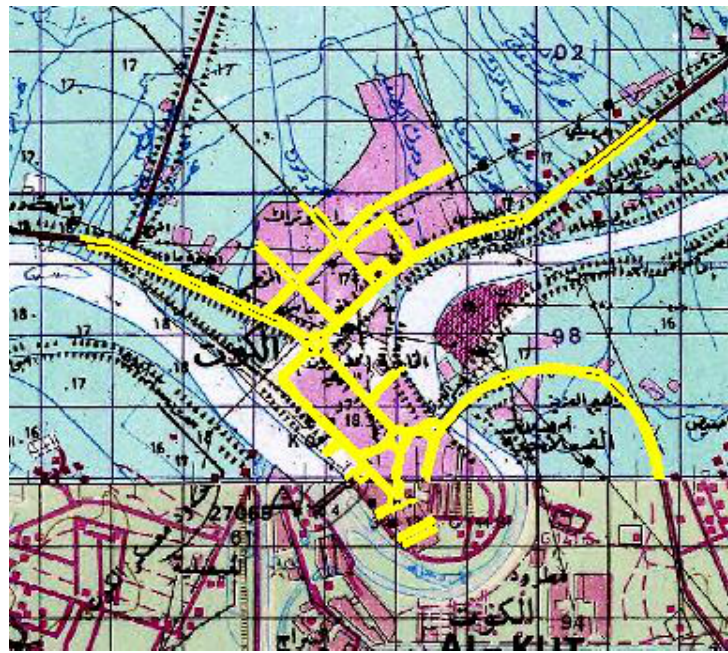
Fig.9: Illustrated the network of roads from map at scale 1:100,000.